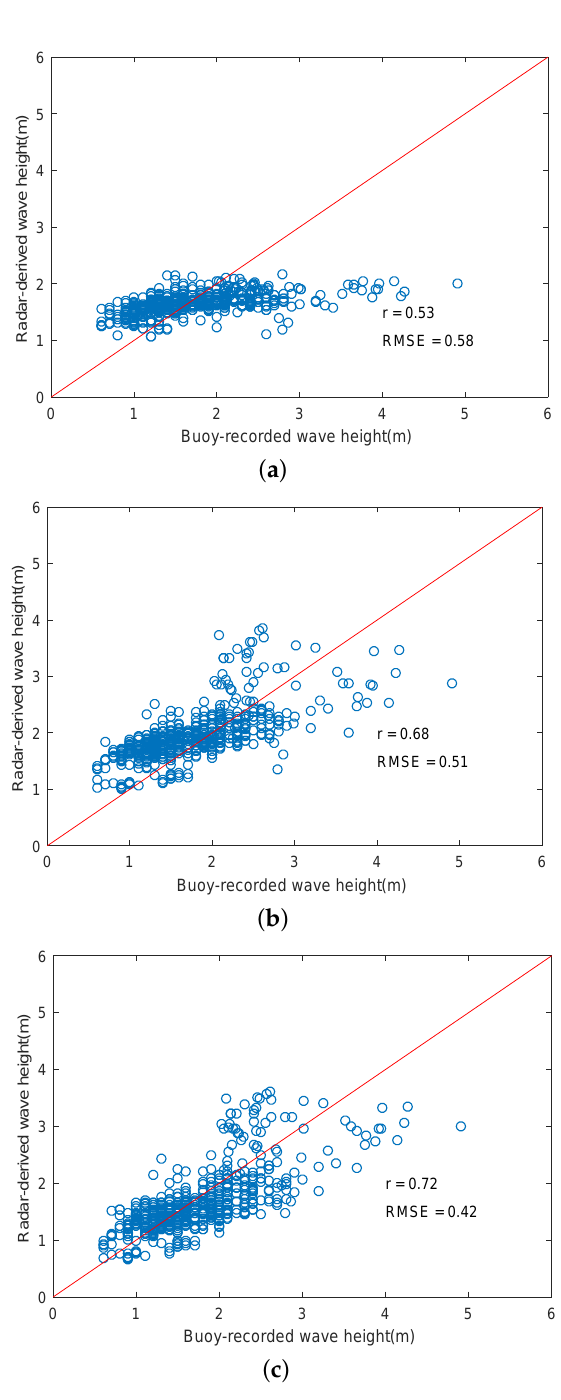
Figure 14. The scatter plots of the significant wave height between the radar-derived and the buoy-derived. ( a ) The original algorithm; ( b ) The modified algorithm. ( c ) The SVR